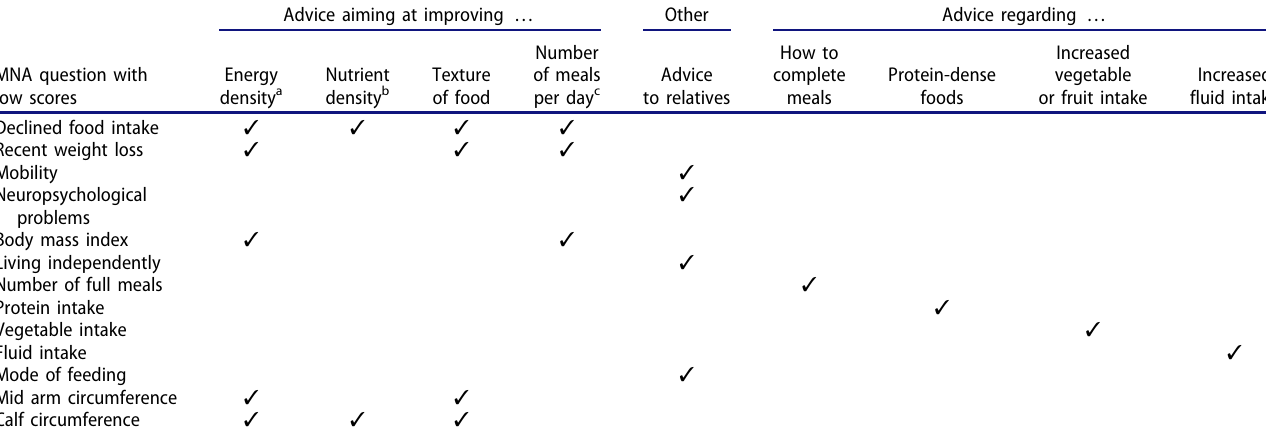
Table 1. Dietary advice given to participants based on the answers from the mini nutritional assessment